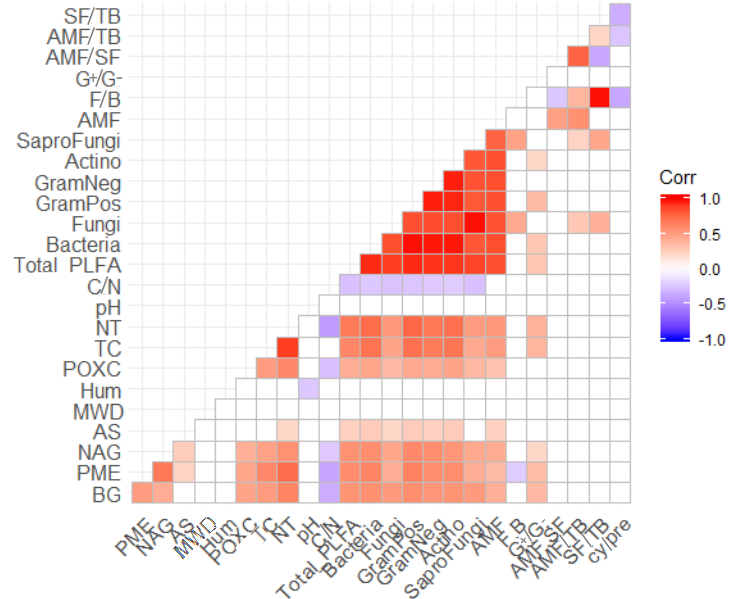
Figure 3. Correlation analysis based on Pearson index. Blue values are negative correlations, red values are positive correlations and white is no significant values. F/B-fungal to total bacterial ratio FAME; G+/G−-Gram-positive to Gram-negative bacterial FAME; AMF/SF-Arbuscular mycorrhiza fungi to saprophytic fungi FAME; AMF/TB-Arbuscular mycorrhiza fungi to total bacteria FAME; SF/TB-saprophytic fungi to total bacteria FAME; and cy/pre-cyclopropyl to precursor FAME; AMF-Arbuscular mycorrhiza fungi; SaproFung-Saprophytic fungi; Actino-actinomycetes; GramNeg-Gram-negative; GramPos-Gram-positive; C/N-Total organic carbon to total nitrogen; TN-total nitrogen; TC-total carbon; POXC-permanganate oxidable carbon; moisture-gravimetric soil moisture; MWD-mean weight diameter; AS-arylsulfatase; NAG-glucosaminidase; PME; acid phosphatase, and BG-glucosidase.